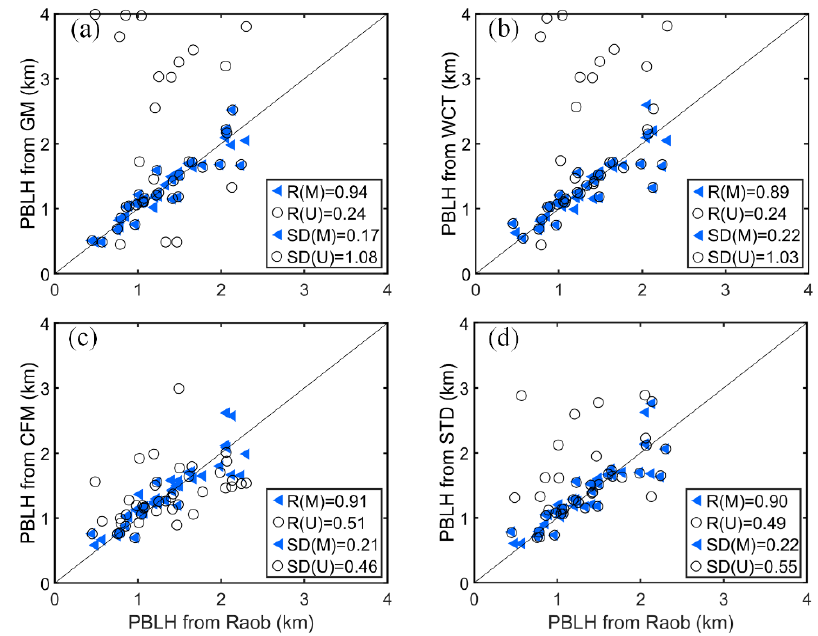
Figure 7. Similar to Figure 6, but in multi-layer conditions.